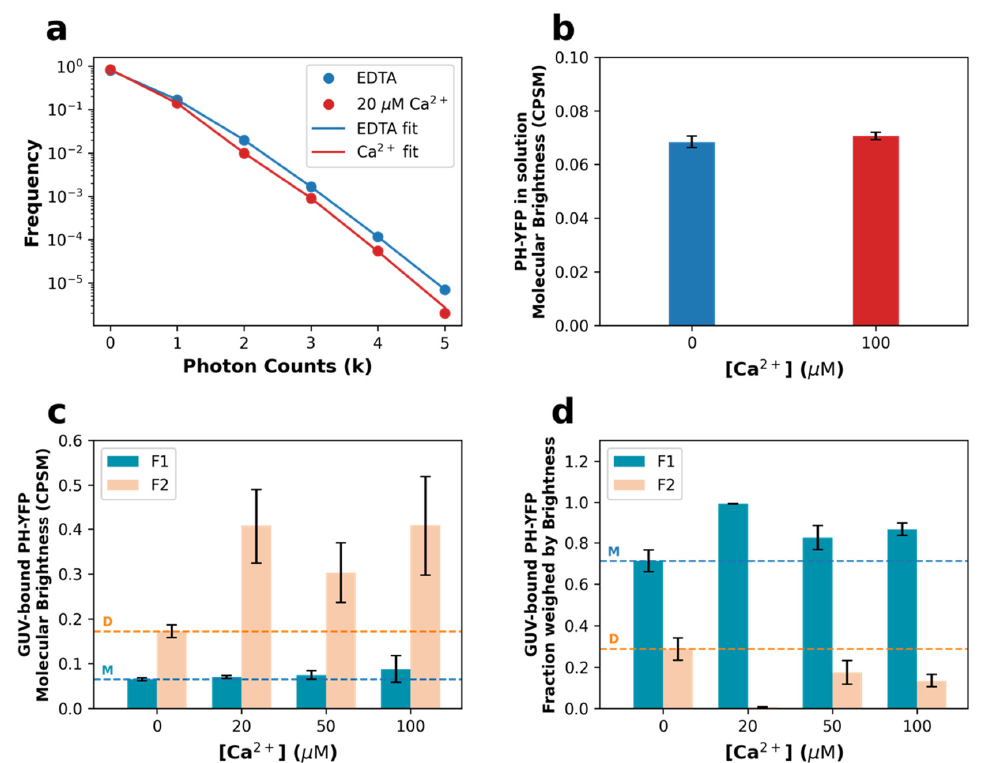
Figure 3. Disruption of PH-YFP oligomerization is dependent on Ca 2+ concentration. ( a ) Representa- tive photon counting histograms of PH-YFP in POPC:PI(4,5)P 2 (95:5 molar ratio) GUVs in the presence (red) and absence (blue) of Ca 2+ . ( b ) Molecular brightness values recovered for PH-YFP in solution in the presence and absence of Ca 2+ . ( c ) Molecular brightness values and ( d ) fractions weighed by brightness recovered for PH-YFP in POPC:PI(4,5)P 2 (95:5 molar ratio) GUVs in the presence and absence of Ca 2+ . Horizontal dashed lines represent the values obtained in the absence of Ca 2+ for the monomer (M, orange) and dimer (D, blue) populations. Values represent means ± standard errors. Values from solution measurements for each condition are averages of four independent samples. Values from GUV measurements for each condition are averages of at least three different GUVs ( N 0 µ M Ca 2 + = 12, N 20 µ M Ca 2 + = 7, N 50 µ M Ca 2 + = 3, N 100 µ M Ca 2 + = 3).